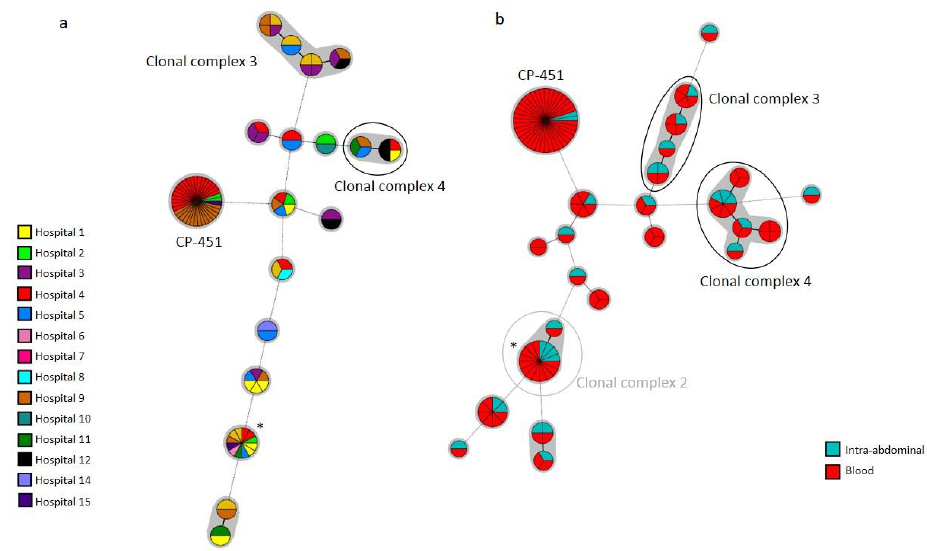
Figure 4. Minimum spanning tree showing C. parapsilosis widespread clusters found in blood cultures shown per hospital of source ( a ) or combined with intra-abdominal samples ( b ). Circles represent different genotypes and circle size the number of isolates belonging to the same genotype. Connecting lines between circles show profile similarities. The solid bold line indicates differences in only 1 marker, solid line indicates differences in 2 markers, dashed line indicates differences in 3 markers, and dotted line indicates differences in 4 or more markers. CP-451 is a resistant genotype. The grey circle depicts the previously reported clonal complex 2. Black circles depict clonal complexes 3 and 4, newly reported herein. * Genotype CP-023. Cluster CP-451 was found in four hospitals and involved a high number of isolates.